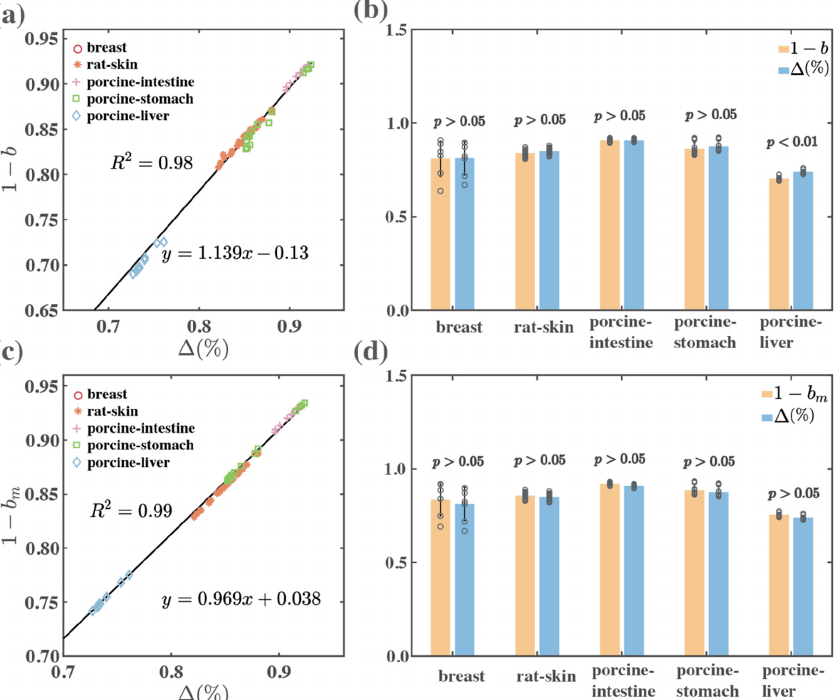
Figure 8. Comparison of MMT and MMPD depolarization parameters of bulk tissue samples. ( a ) Depolarization MMPD parameter Δ plotted against its counterpart MMT parameter 1 − b for correlation analysis with all five kinds of bulk tissue samples. ( b ) Statistical analysis bar chart of depolarization MMPD parameter Δ and MMT parameter 1 − b for each kind of bulk tissue samples. ( c ) Depolarization MMPD parameter Δ plotted against its counterpart MMT parameter 1 − b m for correlation analysis with all five kinds of bulk tissue samples. ( d ) Statistical analysis bar chart of depolarization MMPD parameter Δ and MMT parameter 1 − b m for each kind of bulk tissue sample.